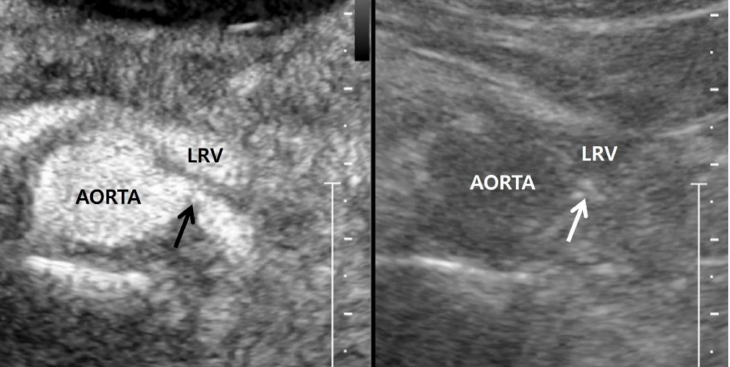
Figure 5. Contrast-enhanced US in a 60-year-old man. Contrast-enhanced US axial image ( left side ), which was obtained 20–30 s after Sonovue (Bracco, Milan, Italy) was intravenously injected, shows a focal stenosis in the proximal left renal artery. Gray-scale US axial image ( right side ), which corresponds to the contrast-enhanced US axial image, shows calcifications (white arrow) in the stenotic wall of the proximal left renal artery. LRV, left renal vein.